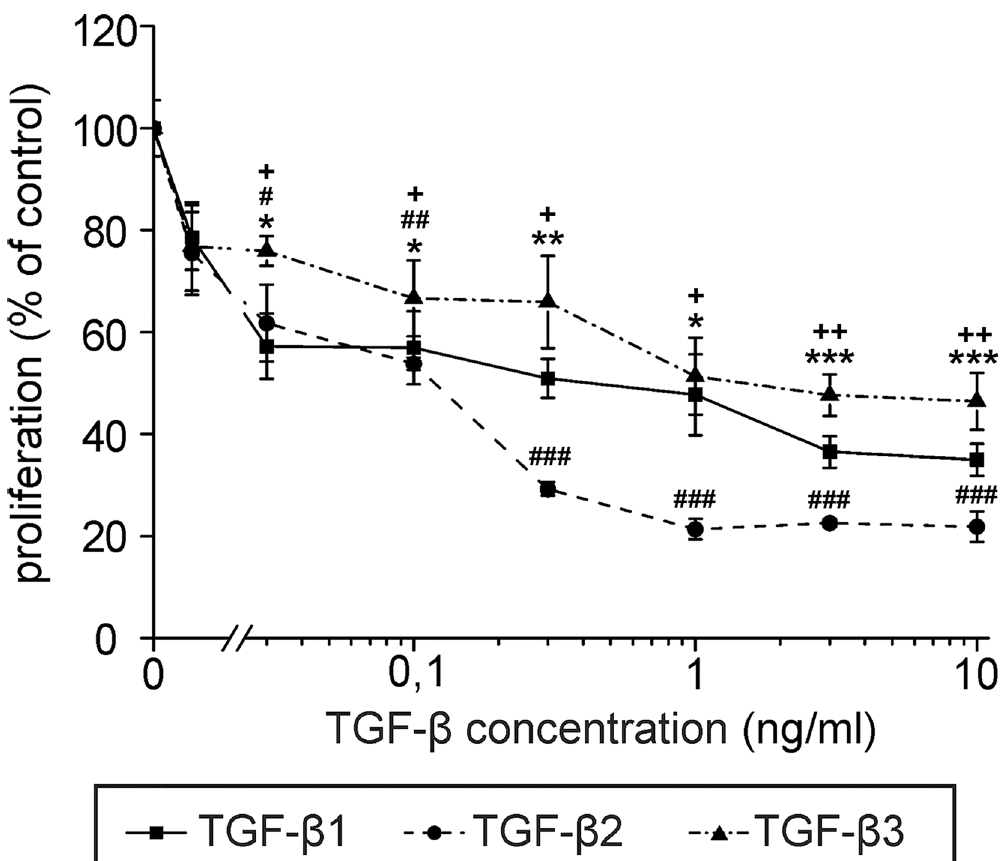
Fig 2. TGF- β 1, - β 2 and - β 3 inhibit the proliferation of LECs. Primary human LECs were incubated with different concentrations of recombinant TGF- β 1, - β 2 or - β 3 or were left untreated and served as control. Proliferation was assessed using 3 H thymidine incorporation assays. Data represent the mean of triplicate samples, error bars indicate +/- standard error. Student ’ s t-test: TGF- β 1 relative to untreated control: * p < 0.05, ** p < 0.005, *** p < 0.001; TGF- β 2 relative to untreated control: # p < 0.05, ## p < 0.005, ### p < 0.001; TGF- β 3 relative to untreated control: + p < 0.05, ++ p < 0.005, +++ p < 0.001. The experiment shown is representative of three independent